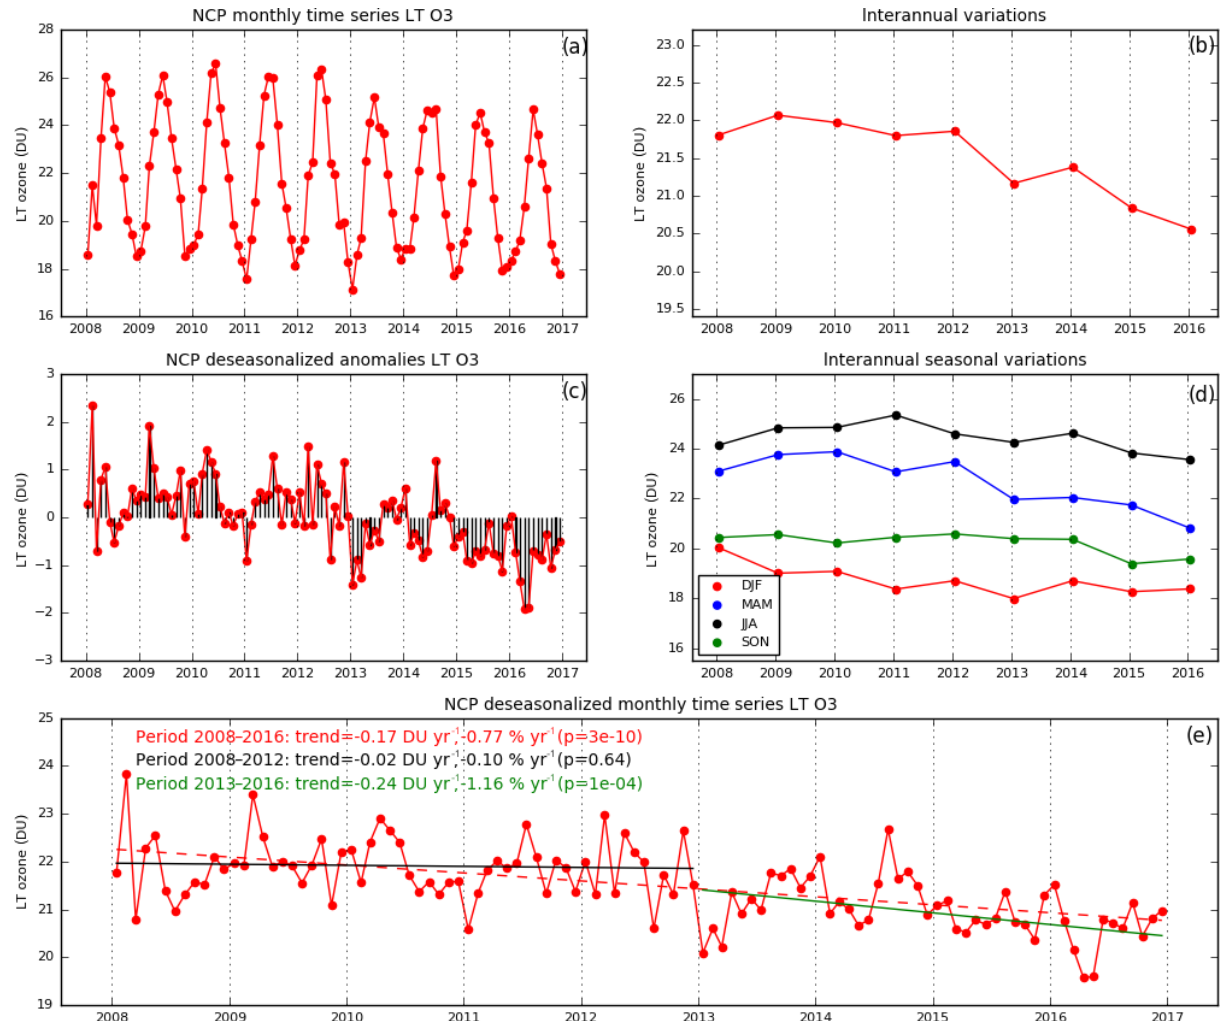
Figure 6. Monthly, annual, and seasonal evolution of LT ozone over the NCP between 2008 and 2016 derived from IASI-A. (a) Monthly time series, (b) annual time series, (c) anomalies, (d) interannual variation of seasonal means, and (e) deseasonalized monthly time series with linear regression calculated for the 2008–2016 period (red), the 2008–2012 period (black), and the 2013–2016 period (green). The 2013 breakpoint of the deseasonalized time series (e) is chosen according to the significant change noticed in the annual time series (b) (see text for